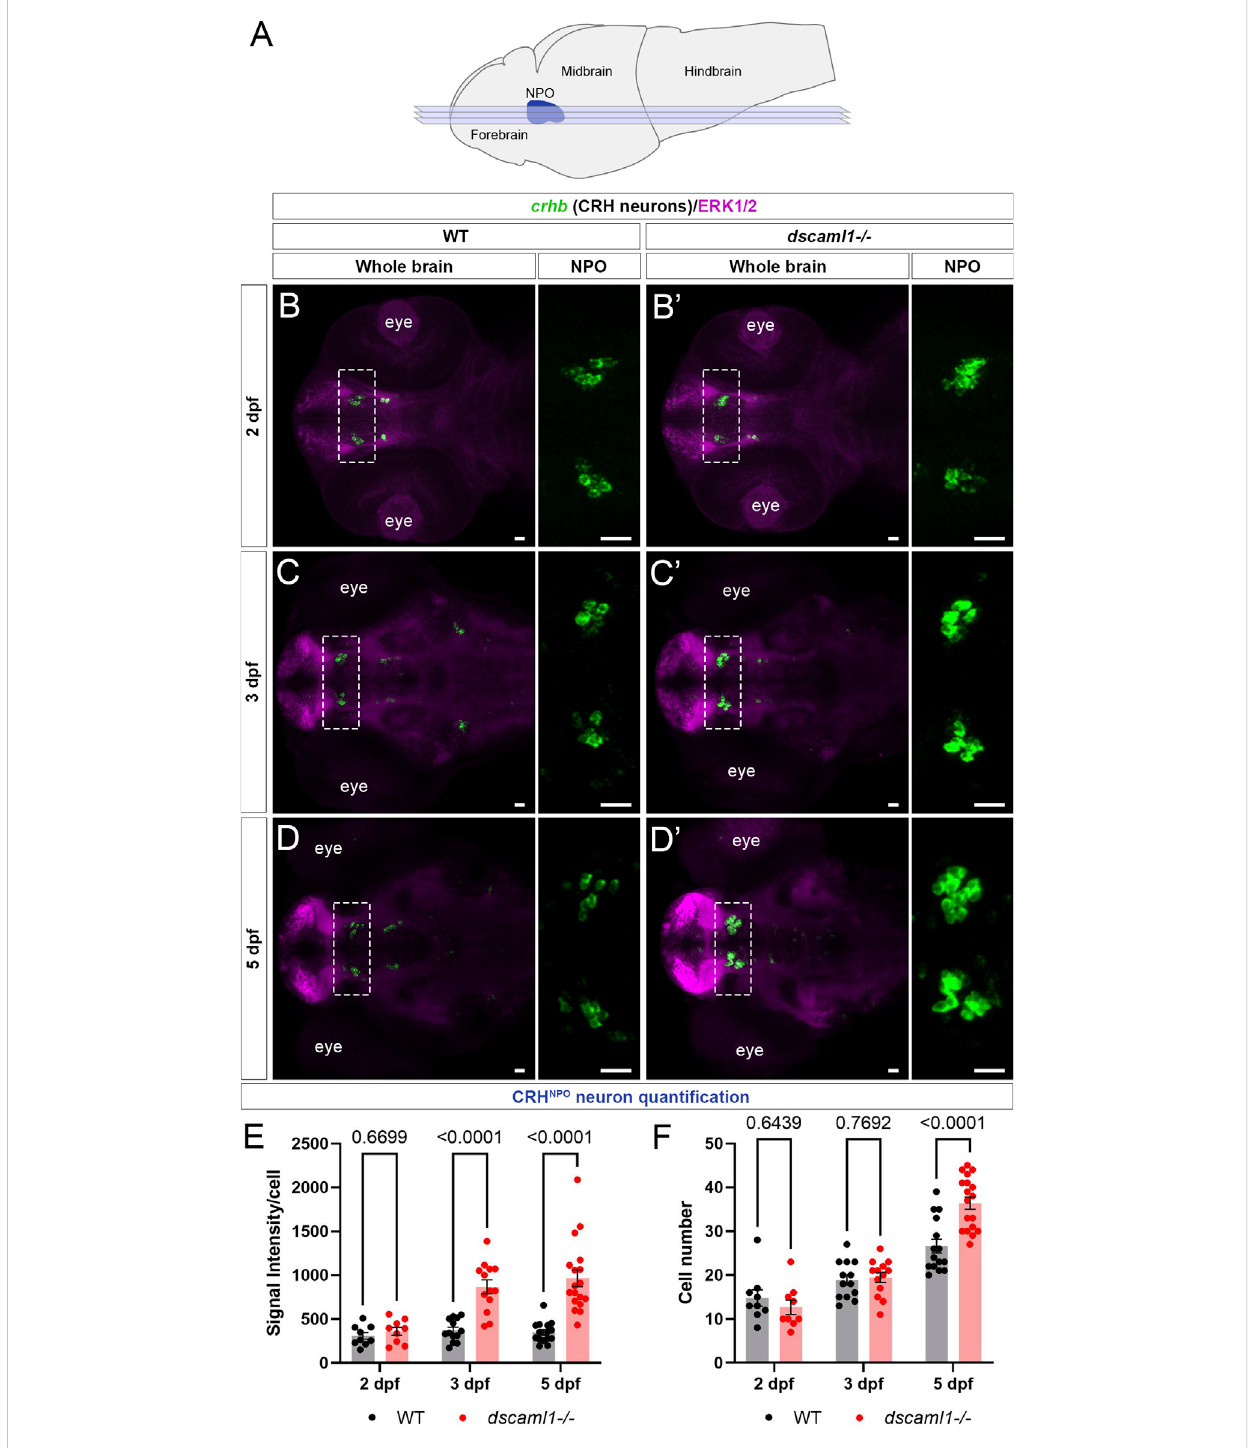
dscaml1 de fi ciency alters the development of CRH NPO neurons. (A) Illustration of the larval zebra fi sh brain (lateral view) with rostral to the left. The NPO is highlighted in blue. Imaging planes used for CRH NPO neuron analysis are shown (light blue planes) (B-D ’ ) Developmental trajectory of CRH NPO neurons, labeled by crhb FISH (green) and co-stained with anti-ERK1/2 (magenta). At each developmental stage, a representative confocal sub-stack containing the NPO is shown, with the NPO (boxed region) enlarged and shown in the right panel without the ERK1/2 co-stain. Wild-type (WT) animals are shown inpanels B,C, and (D) dscaml1 − / − animals are shown in panels B ’ , C ’ , and D ’ (E – F) Quanti fi cation ofthe signal intensity per cell (E) and cell number (F) . Multiple-comparison corrected p values are as shown. WT: n = 9 (2 dpf), 13 (3 dpf), 15 (5 dpf). dscaml1 − / − : n = 9 (2 dpf), 13 (3 dpf), 18 (5 dpf). Scale bars are 20 μ m. Mean, standard error, and corrected p values are